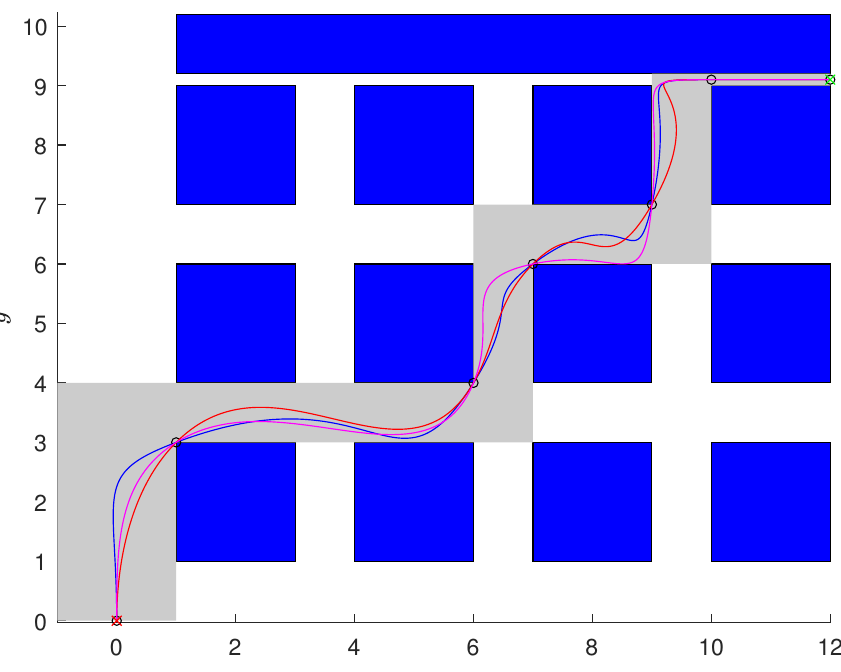
Figure 4. In example 1 the paths should start in the red cross and finish in the green one and be contained in the grey area. They are constructed by Algorithm 1: red curve is obtained by manually chosen free parameters (orientations and curvatures in waypoints), blue—the free parameters are obtained by the algorithms in Sections 3.1 and 3.2, magenta—the free parameters are obtained by optimization.